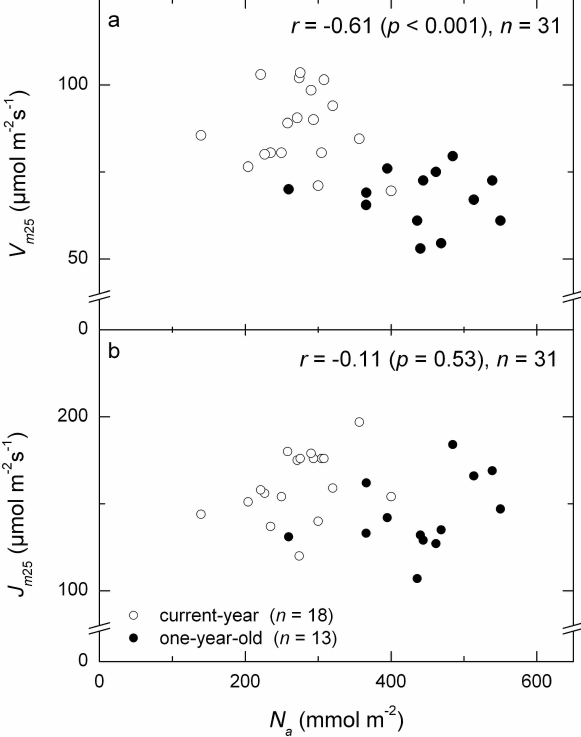
Fig. 3. Scatter plots of (a) maximum carboxylation capacity at 25 ◦ C ( V m25 ) versus area-based needle nitrogen content ( N a ) , and (b) potential electron transport capacity at 25 ◦ C ( J m25 ) ver- sus N a , for current-year needles (open symbols) and one-year-old needles (filled symbols). Data are from July and August 2007. r =correlation